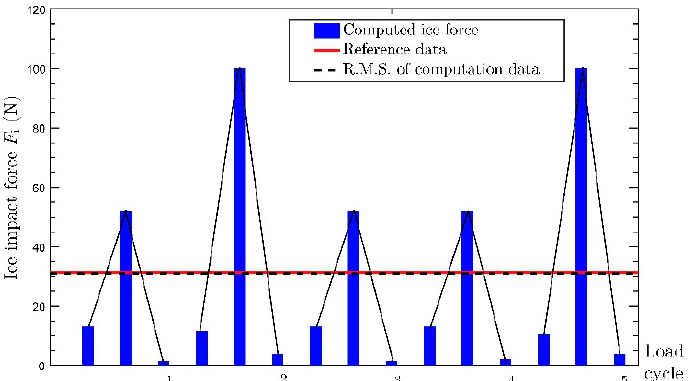
Figure 17. A fraction of ice impact load extracted from Case 1.1.